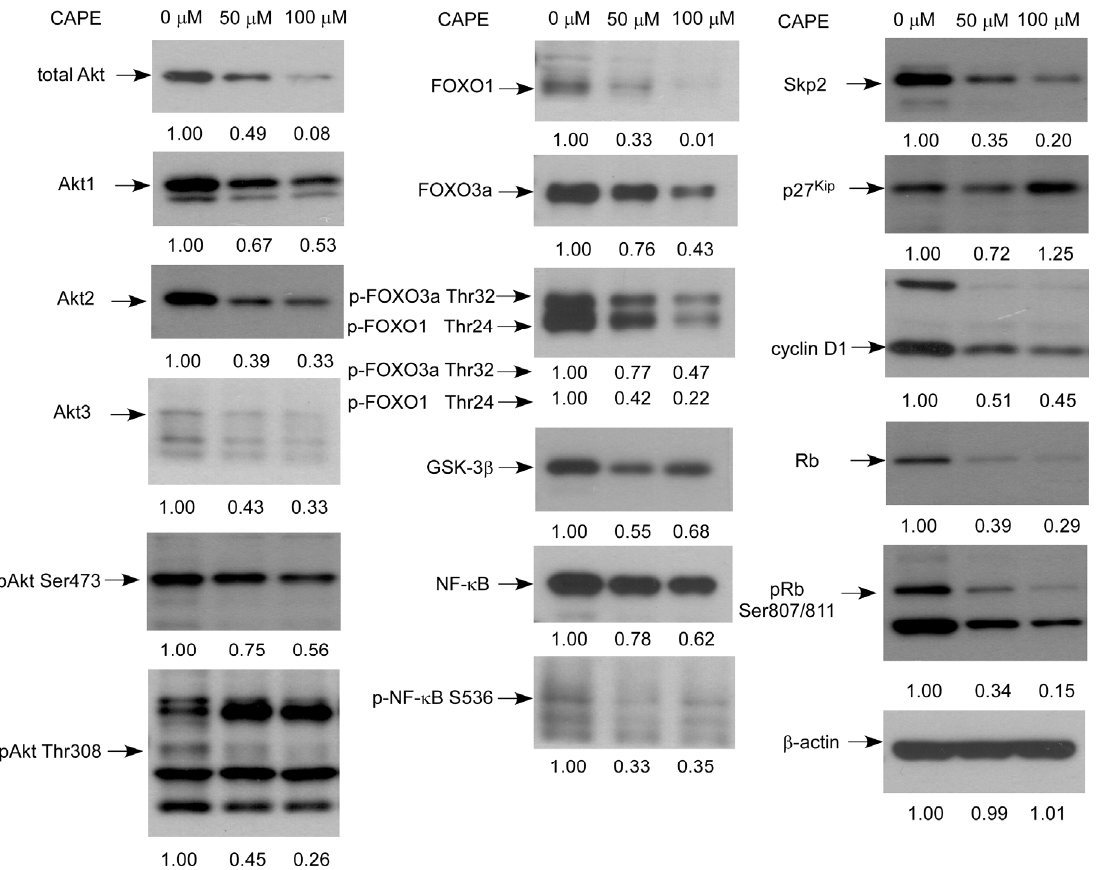
Figure 5. Effects of CAPE treatment on the abundance and phosphorylation status of signaling proteins. Protein expression of total Akt, Akt1, Akt2, Akt3, phospho-Akt Ser473, phospho-Akt Thr308, GSK3 β , Rb, phospho-Rb Ser807/811, cyclin D1, and Skp2, FOXO1, FOXO3a, phospho-FOXO1 Thr24, phospho-FOXO3a Thr32, NF-  B, phospho-NF-  B Ser536, p27 Kip , and β -actin in TW2.6 cells treated with 0, 50, or 100 μ M CAPE for 48 h were assayed by Western blotting. Experiments were repeated three